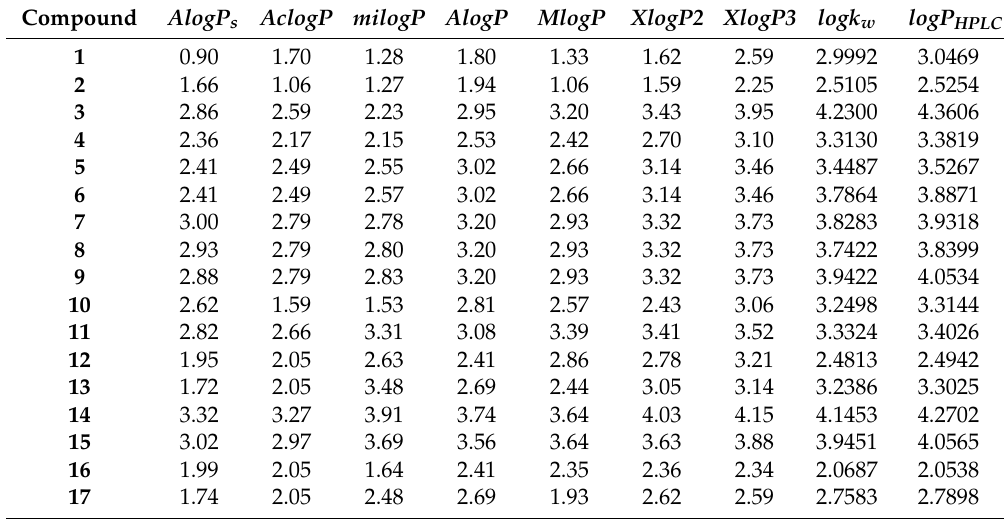
Table 2. The values of calculated and experimental lipophilicity parameters of thiosemicarbazides 1 – 17 .